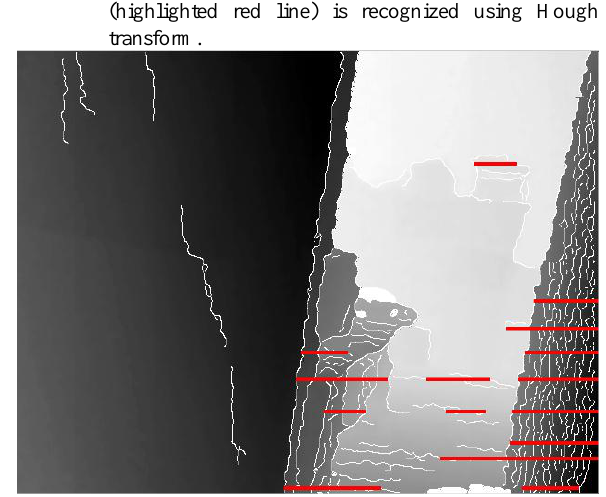
Figure 13. False horizontal lines recognized by Hough